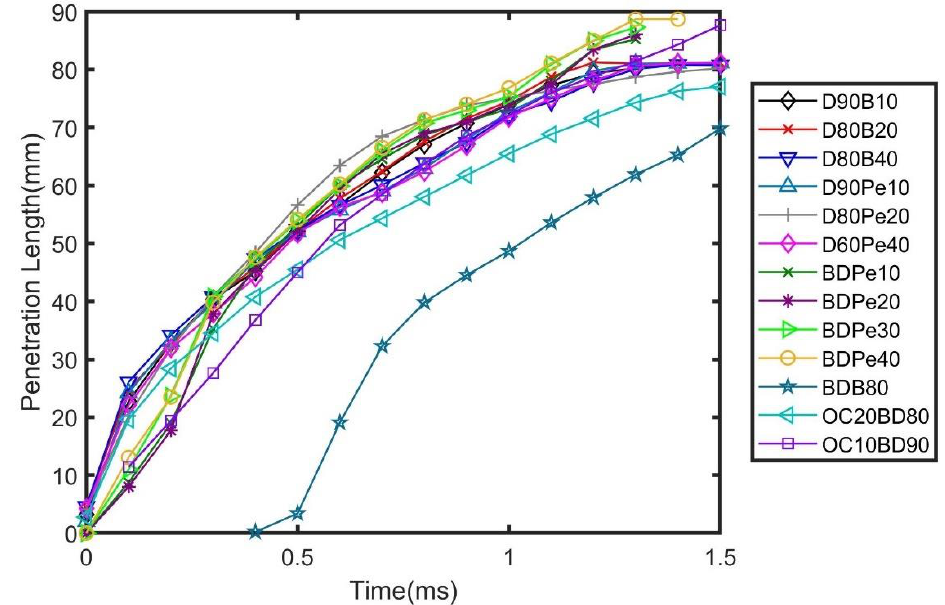
Figure 4. PL for various fuel blends of butanol, pentanol, and octanol with diesel at 100 MPa FIP and 2 MPa ambient pressure [19,55].